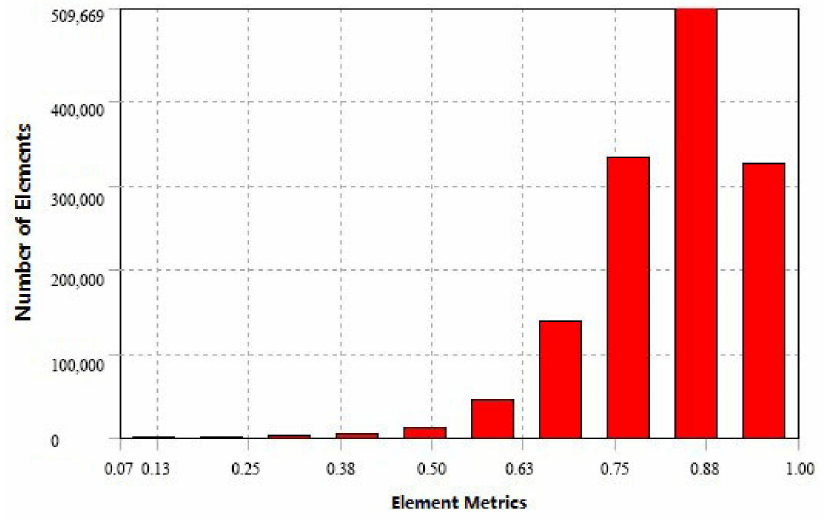
Figure 7. Mesh element